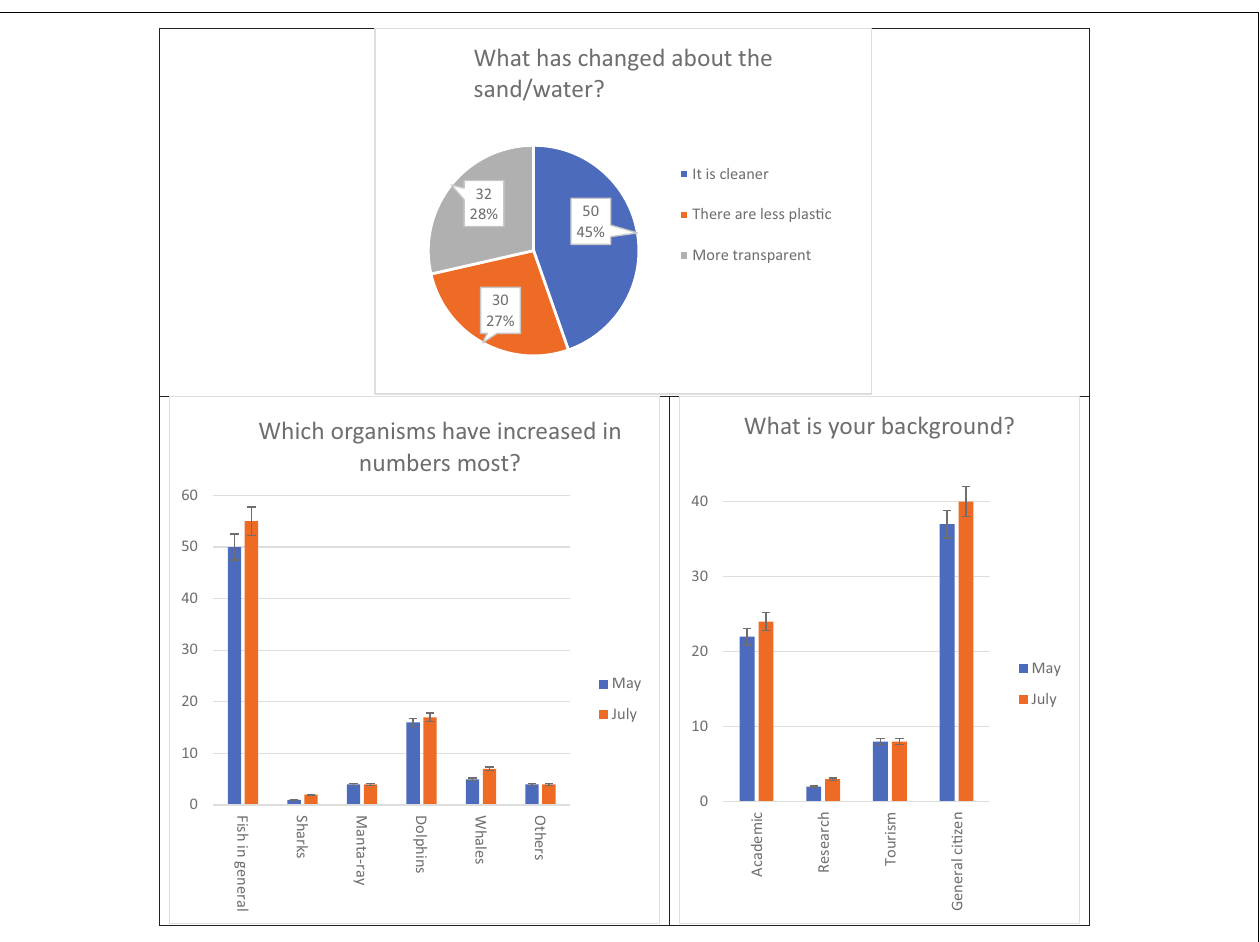
FIGURE 2 | Results from Salinas.